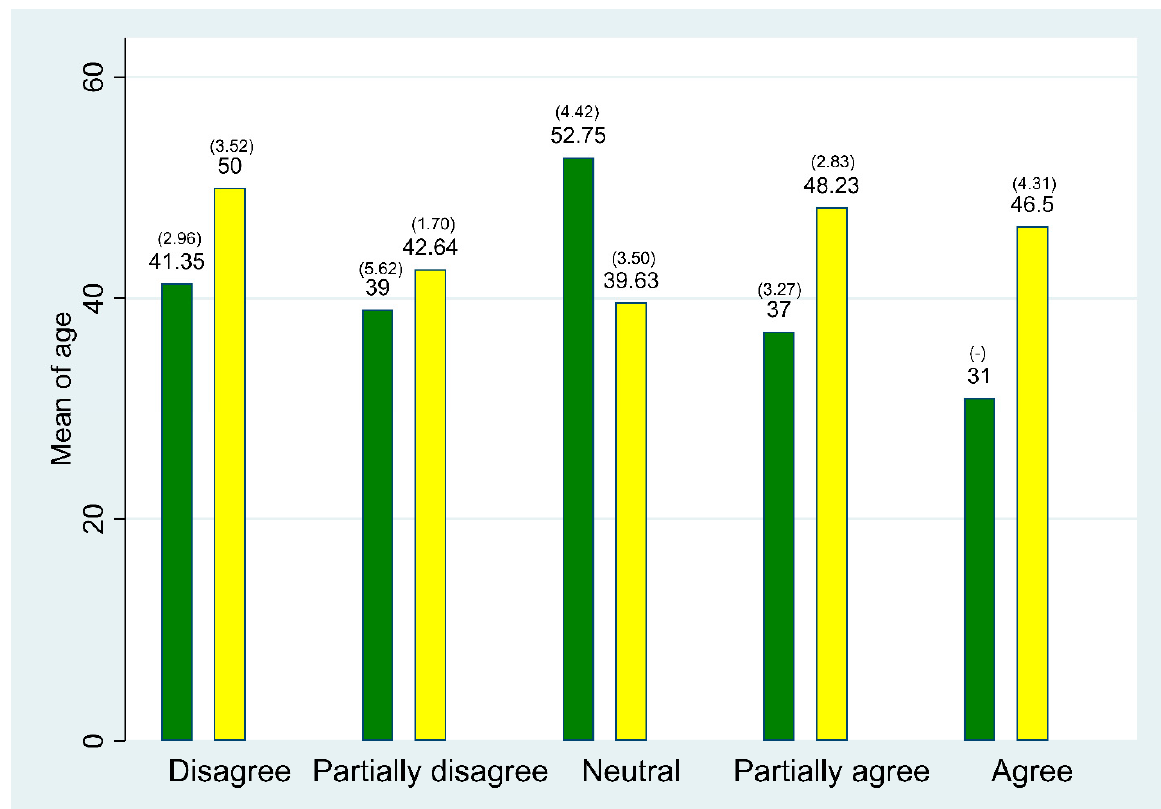
Figure 3. The distribution of mean age in each professional groups when answering the following question: “It worries me having to transition from traditional pathology to DIPA”. (SE). Green: Laboratory technicians. Yellow: Pathologists. Due to a too small group of respondents, the secretaries are left out of the figure.